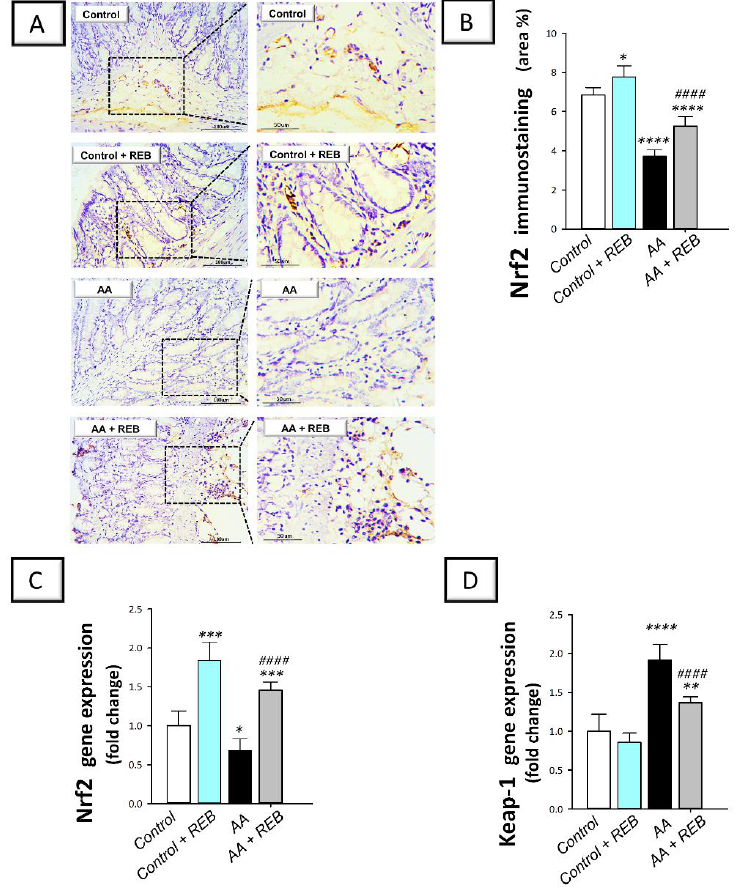
Figure 8. Rebamipide stimulates the colonic Nrf2/Keap-1 pathway and augments the cytoprotective signal PPAR-γ in rats exposed to acetic acid-induced colitis. ( A ) Immunostaining of the nuclear factor erythroid 2-related factor 2 (Nrf2) in the colonic tissue. ( B ) Quantification of colonic Nrf2 immunostaining. ( C ) Gene expression levels of Nrf2 in the colonic tissue. ( D ) Gene expression levels of Kelch-like ECH-associated protein-1 (Keap-1) in the colonic tissue. Each bar represents the mean ± S.D. ( n = 6 for Nrf2 immunostaining and n = 7 for the gene expression data). A one-way ANOVA statistical test was conducted to analyze the significant difference among tested groups followed by a Tukey’s test. * p < 0.05, ** p < 0.01, *** p < 0.001, or **** p < 0.0001, significant from the control group. # ### p < 0.0001, significant from the colonic injury group. REB, rebamipide; AA, acetic